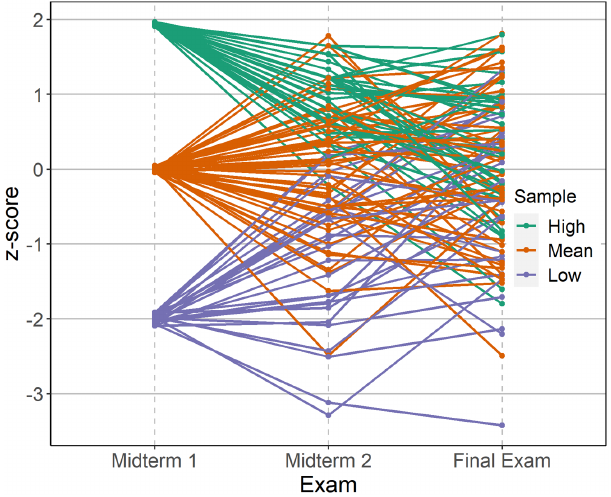
FIG. 1. Evolution of exam z scores for a sample of students: all students with a midterm 1 z score near 2.0 ( “ High ” ), near 0.0 ( “ Mean ” ), and near − 2 . 0 ( “ Low ” ).